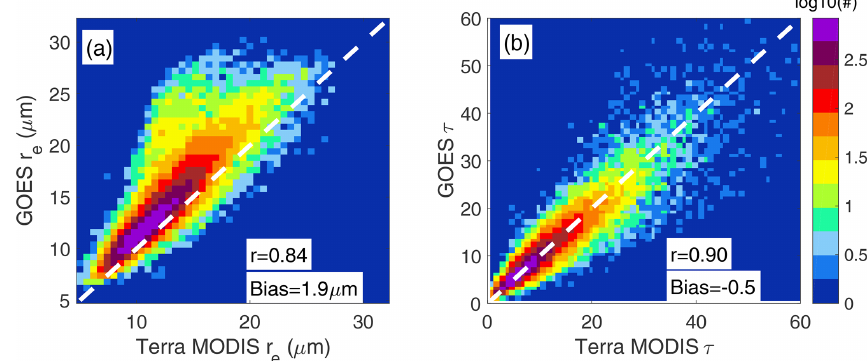
Figure 7. Bivariate histogram between Terra MODIS and GOES-13 (a) r e and (b) τ . One-to-one line is denoted by the white dashed lines. Bias represents the mean difference between GOES-13 and